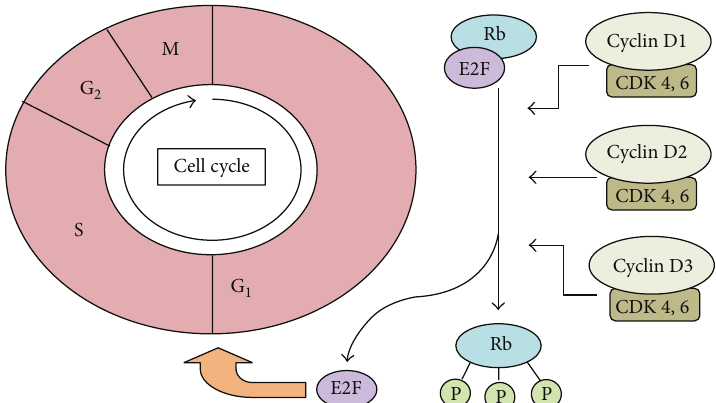
Figure 2: Overexpression of cyclin D genes influence cell cycle progression at the G /S transition point in myeloma . Increased cyclin D gene 1 expression through hyperdiploid or nonhyperdiploid events in myeloma facilitates activation of a cyclin-dependent kinase (CDK 4 or 6). The respective CDK then phosphorylates Rb (retinoblastoma protein), which subsequently resides from its role inhibiting E2F transcription factors allowing these to facilitate cell cycle progression at the G 1 /S transition. G 1 : Gap-1 phase; S: synthesis phase; G2: Gap-2 phase; M: mitosis; P: phosphate